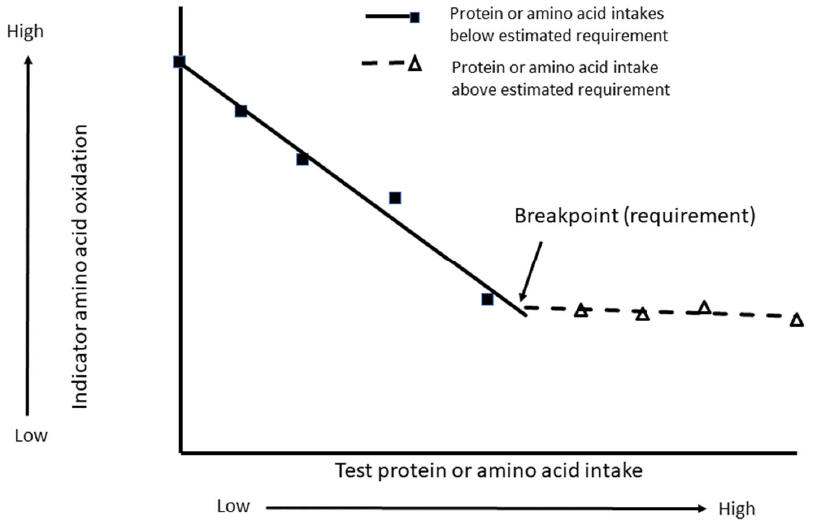
Figure 1. Determination of a test amino acid requirement based on the oxidation of an indicator amino acid (theoretical data) and employing the biphasic linear regression technique.